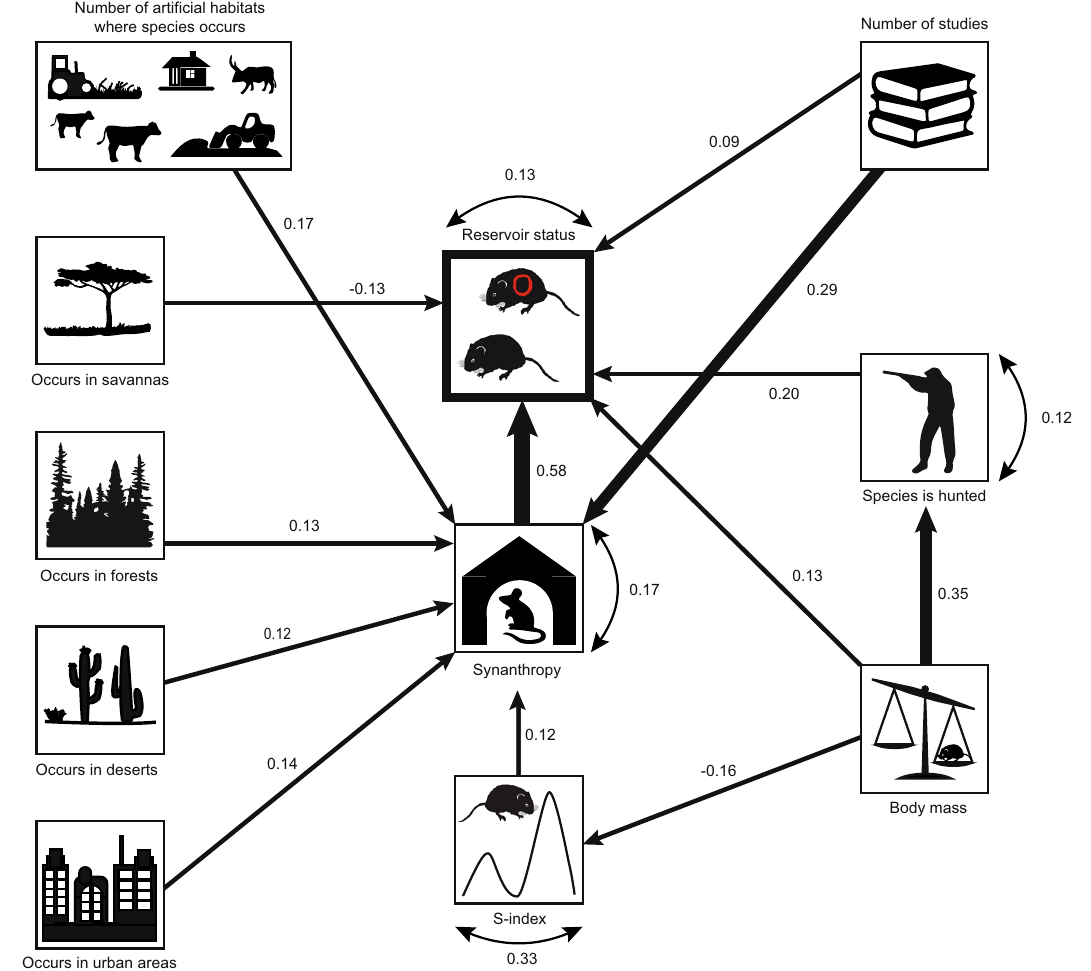
Fig. 2 | Predictors of reservoir status. Final structural equation model linking reservoir status of rodent species ( n =269) with their synanthropy and hunting status, population fl uctuations (s-index, log-transformed), and adult body mass, controlling for their occurrence in a range of habitats and the number of studies available per species. One-sided (directional) arrows represent a causal in fl uence